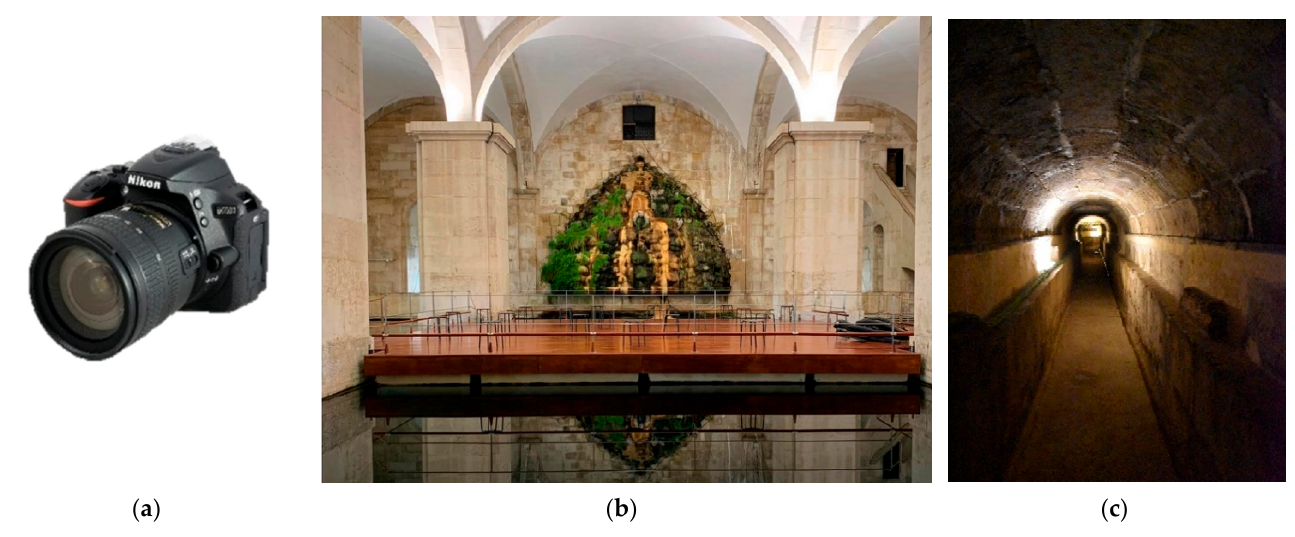
Figure 7. ( a ) Nikon D5500 camera; ( b , c ) Images captured with reflex camera.